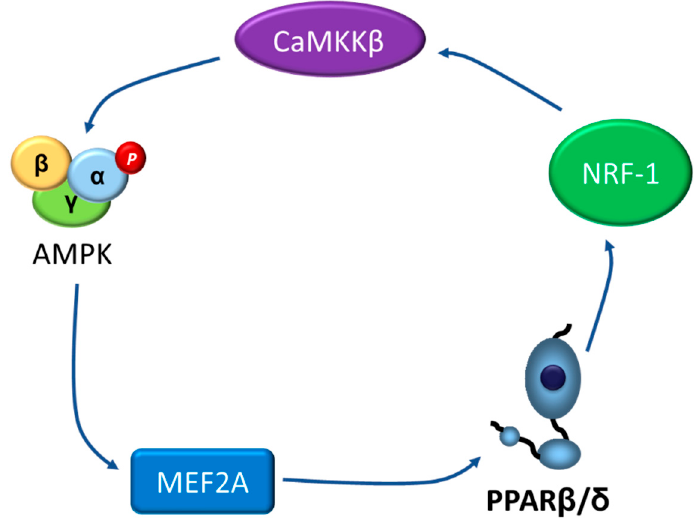
Figure 4. Potential positive loop between activated AMPK, PPAR β / δ , and MEF2A. AMPK, AMP- activated protein kinase; CaMKK β , Ca 2+ /calmodulin-dependent protein kinase kinase- β ; MEF2A, myocyte enhancer factor 2A; NRF-1: nuclear respiratory factor 1; PPAR β / δ , peroxisome proliferator- activated receptor β / δ .